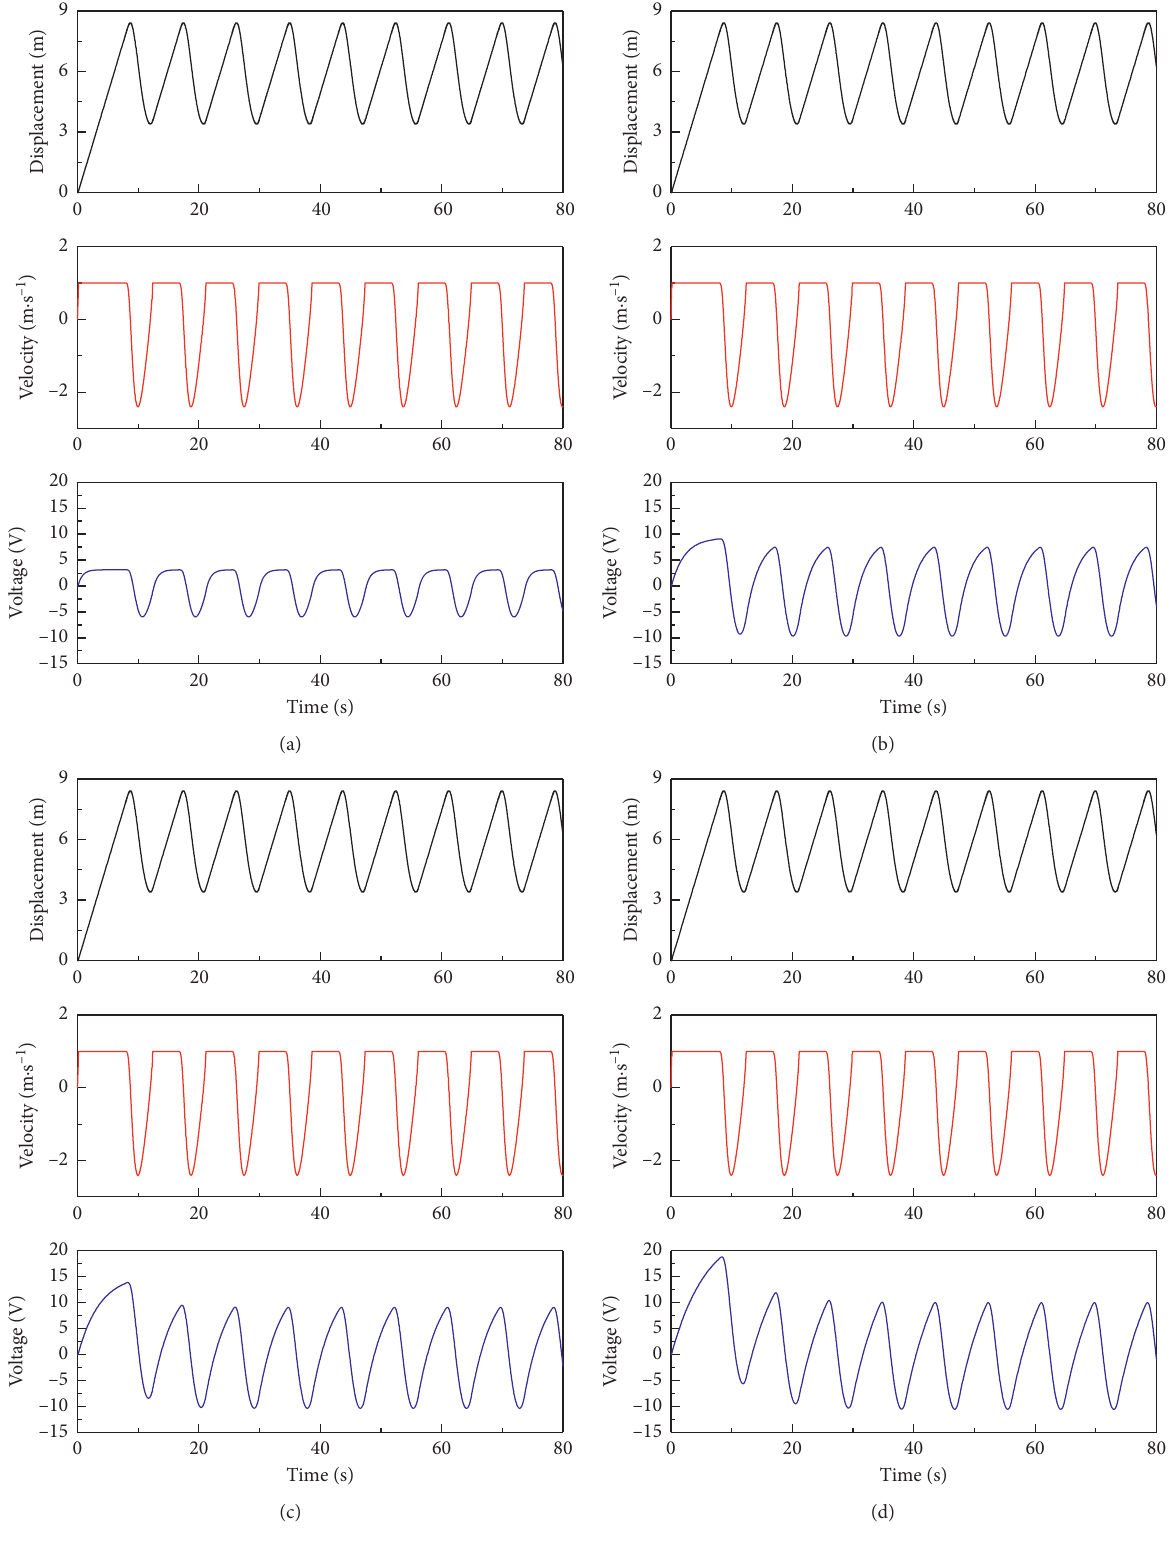
Figure 10: The displacement, velocity, and output voltage of the friction system when the load resistance is R � 100000 Ω (a), R � 300000 Ω (b), R � 500000 Ω (c), and R � 800000 Ω (d) in the friction law